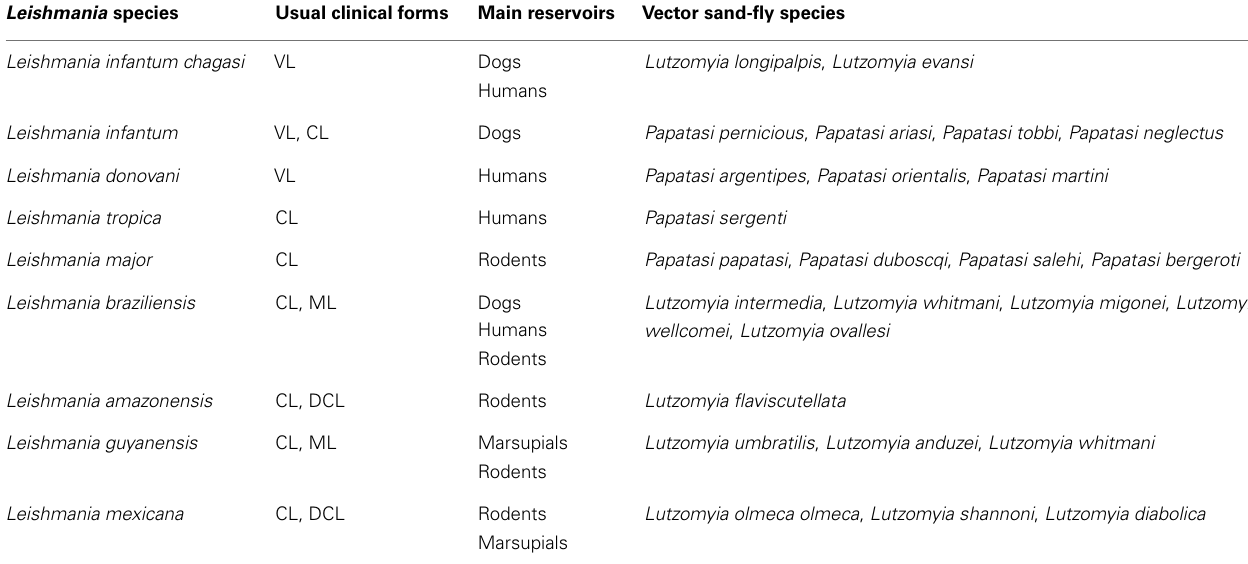
Table 1 | Clinical forms, main reservoirs, and sand-fly vectors of various Leishmania species